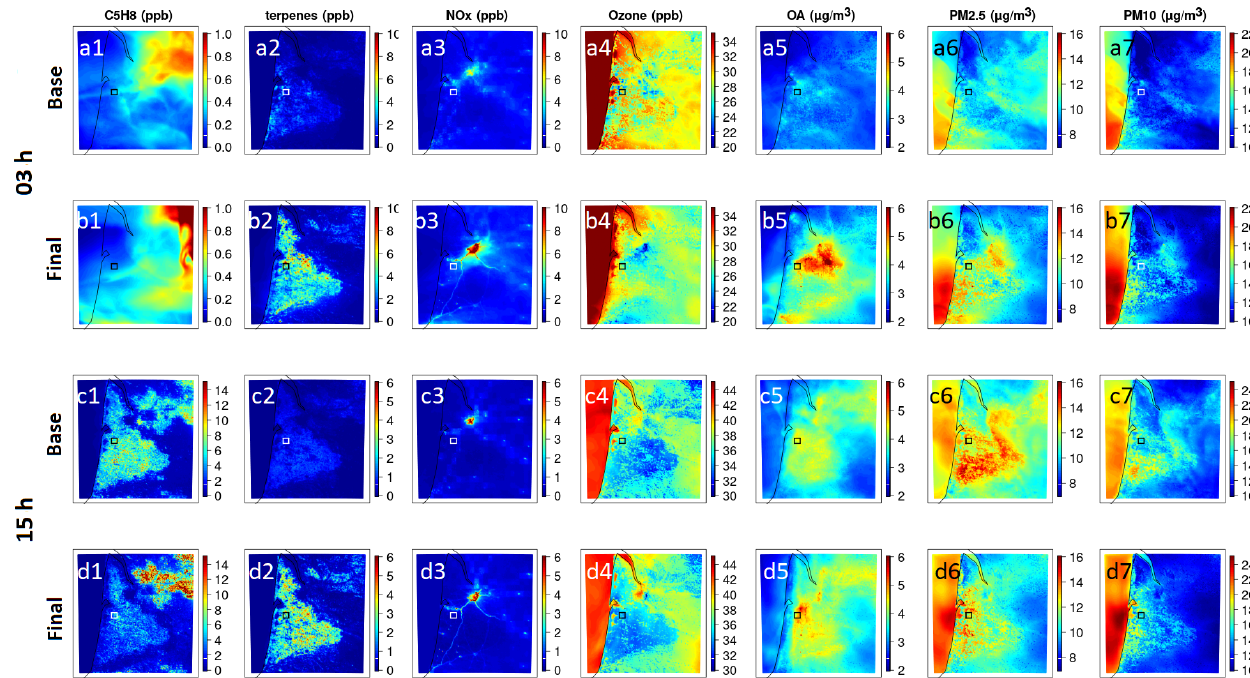
Figure 10. Average concentrations over the campaign period for species of importance for this study (compound names and associated units are written above each column) for 03:00 (first two rows) and 15:00LT (second two rows) for the base simulation (first and third rows) and final simulation (second and fourth rows). Note that the scales are different for each plot. The measurement site at Salles-Bilos is located in the middle of the white or black rectangle in each plot.